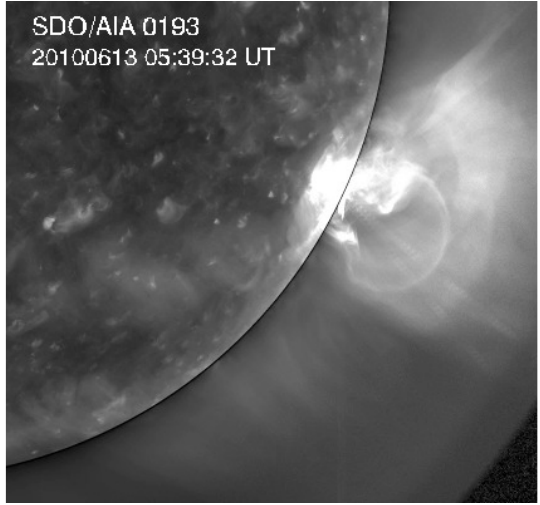
Figure 39: Still from a movie – An animation of the coronal wave of 2010 Jun 13 observed at ultra- high cadence with SDO/AIA. Shown are base images at 193 ˚A. Note the coronal wave forming ahead of the expanding CME bubble. Reproduced with permission from Ma et al. (2011), copyright by AAS. (To watch the movie, please go to the online version of this review article at http://www.livingreviews.org/ lrsp-2015-3